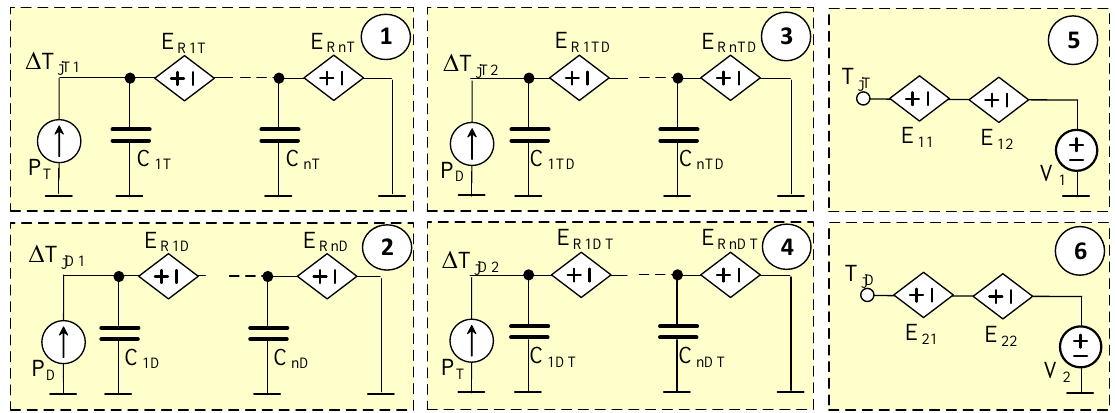
Figure 2. Network representation of the compact thermal model of the IGBT mounted in the same case with the anti- parallel diode.